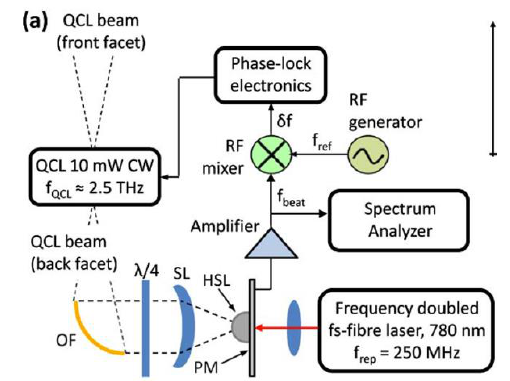
Fig. 2. Block-diagram of QCL phase-locking taken form [16]. THz field from the QCL is mixed with the photocarrier THz comb induced in the PM by the fs pulse train generated in fiber laser with repetition rate of 250